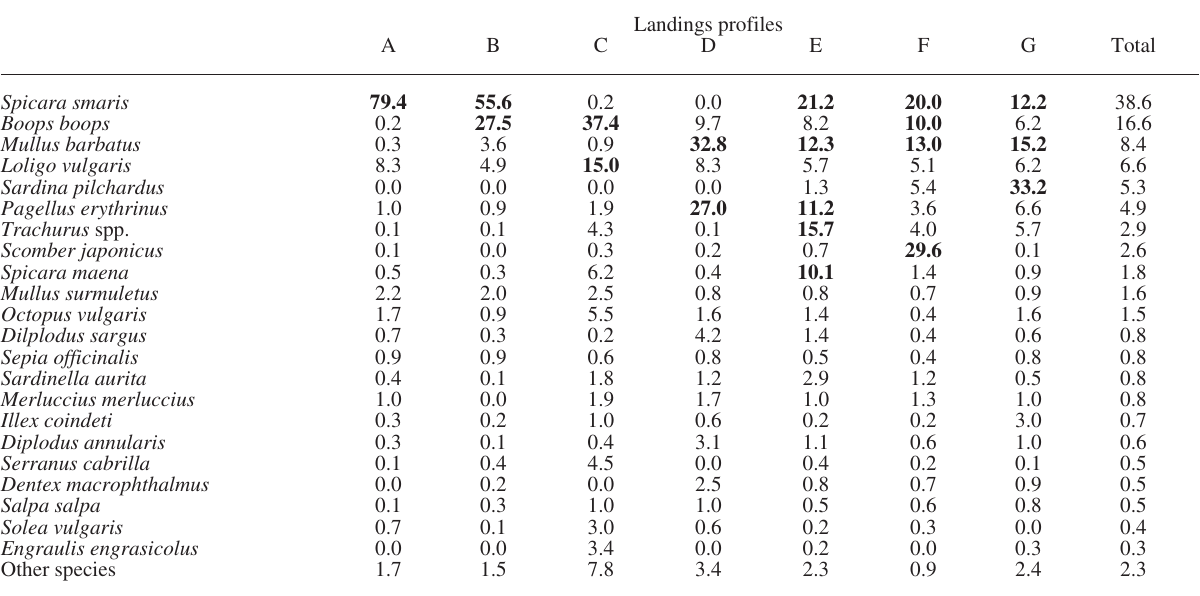
Table 1. – average landings profiles of the 7 clusters identified in the aegean Sea (Fig. 4), given as the proportion (%) of the landings of each species to the total landings of each cluster. the most important species of each profile (with a proportion in landings >10%) are given in bold.